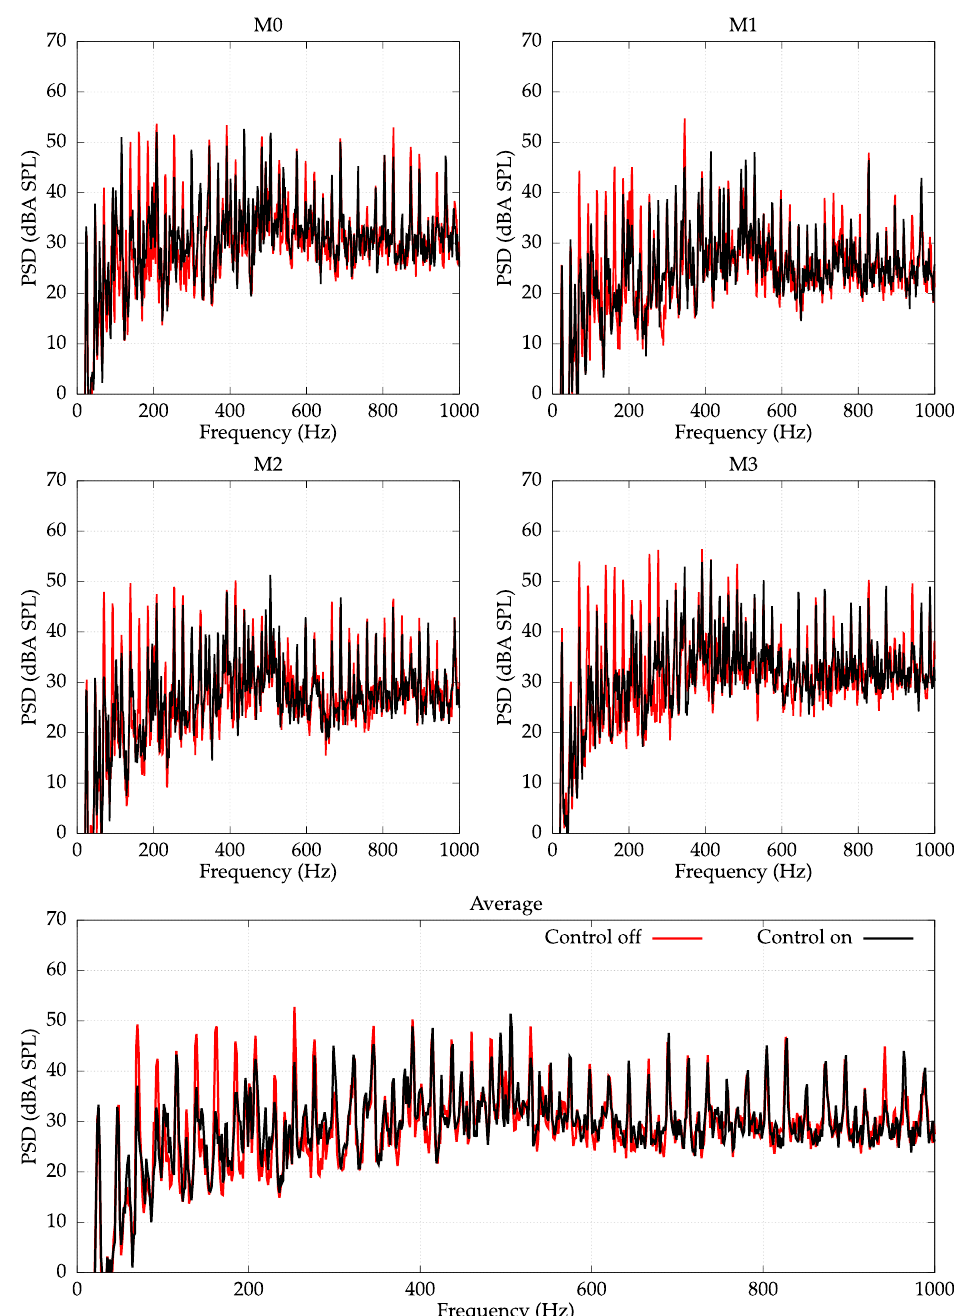
Figure 9. PSD with an A-weighting measured at monitoring microphones M0–M3. Unbalance load of 500 g. Spin velocity 1340 RPM. Average reduction: 3